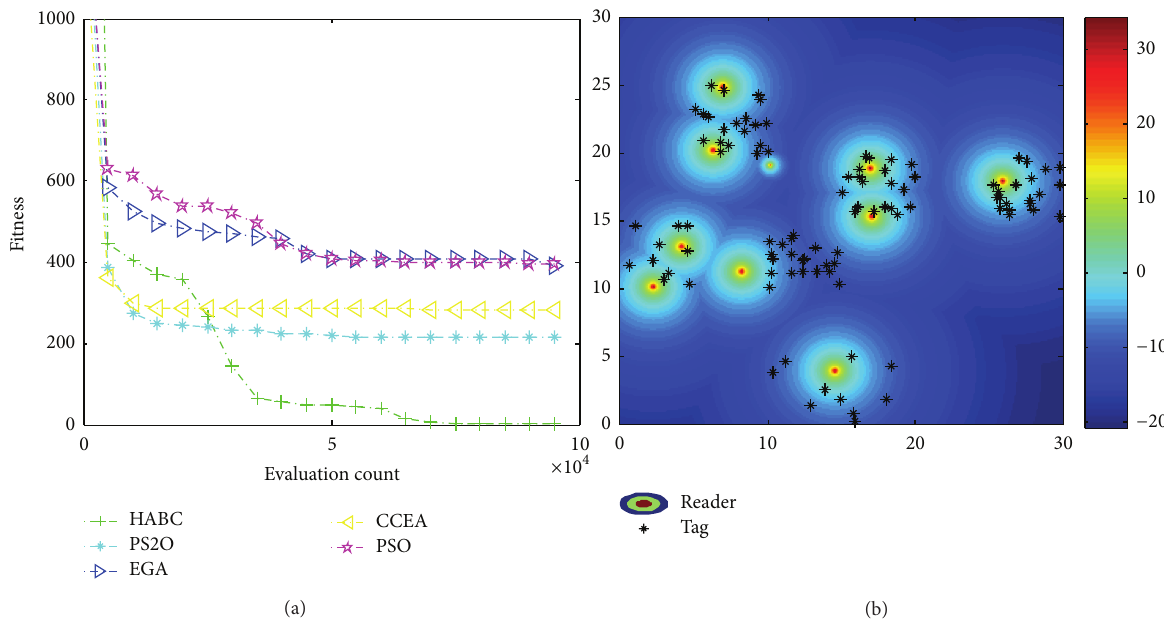
Figure 9: Results only consider tag coverage. (a) Convergence process; (b) reader location and received power distribution.